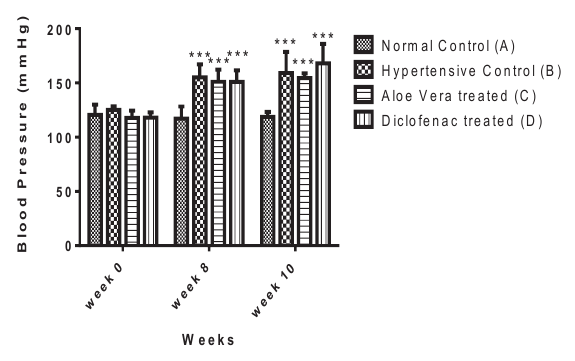
Fig-2: Effect of Aloe vera gel and diclofenac on systolic blood pressure (mean±SD) of hypertensive rats (n=6) *** p value <0.001 Versus Group A Serum Creatinine Serum creatinine concentration of all groups did not change significantly during any comparison time as shown in Fig-3.